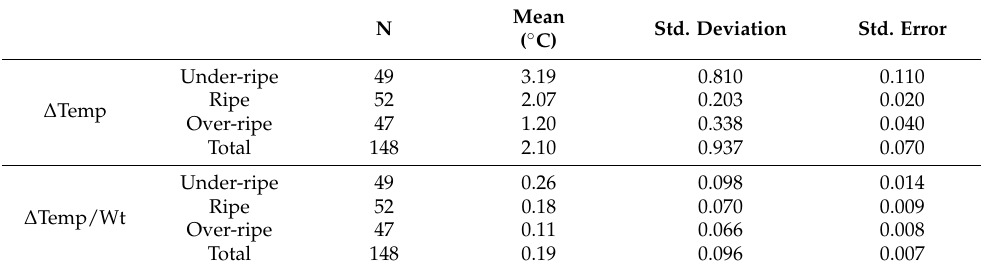
Table 4. Descriptive statistics of ∆ Temp and ∆ Temp/Wt (second experiment).